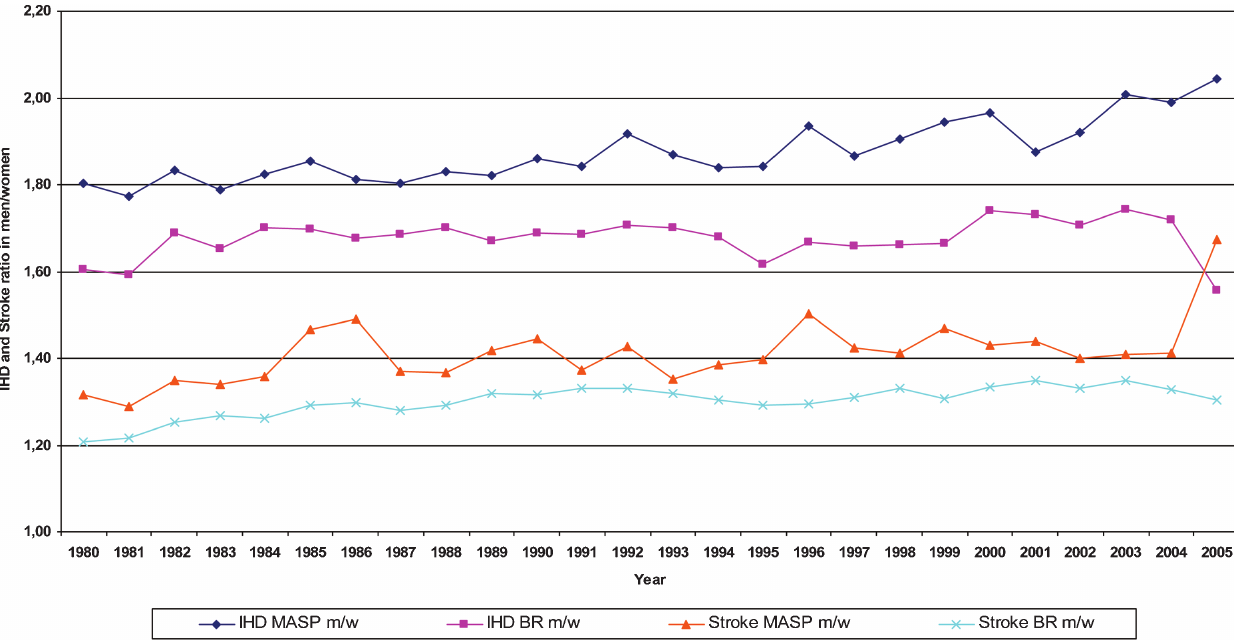
Figure 2 - Ischemic heart disease (IHD) and stroke ratios in women (w) and men (m) $ 30 years of age in Brazil (BR) and in the metropolitan region of Sa˜o Paulo (MASP) from 1980 to